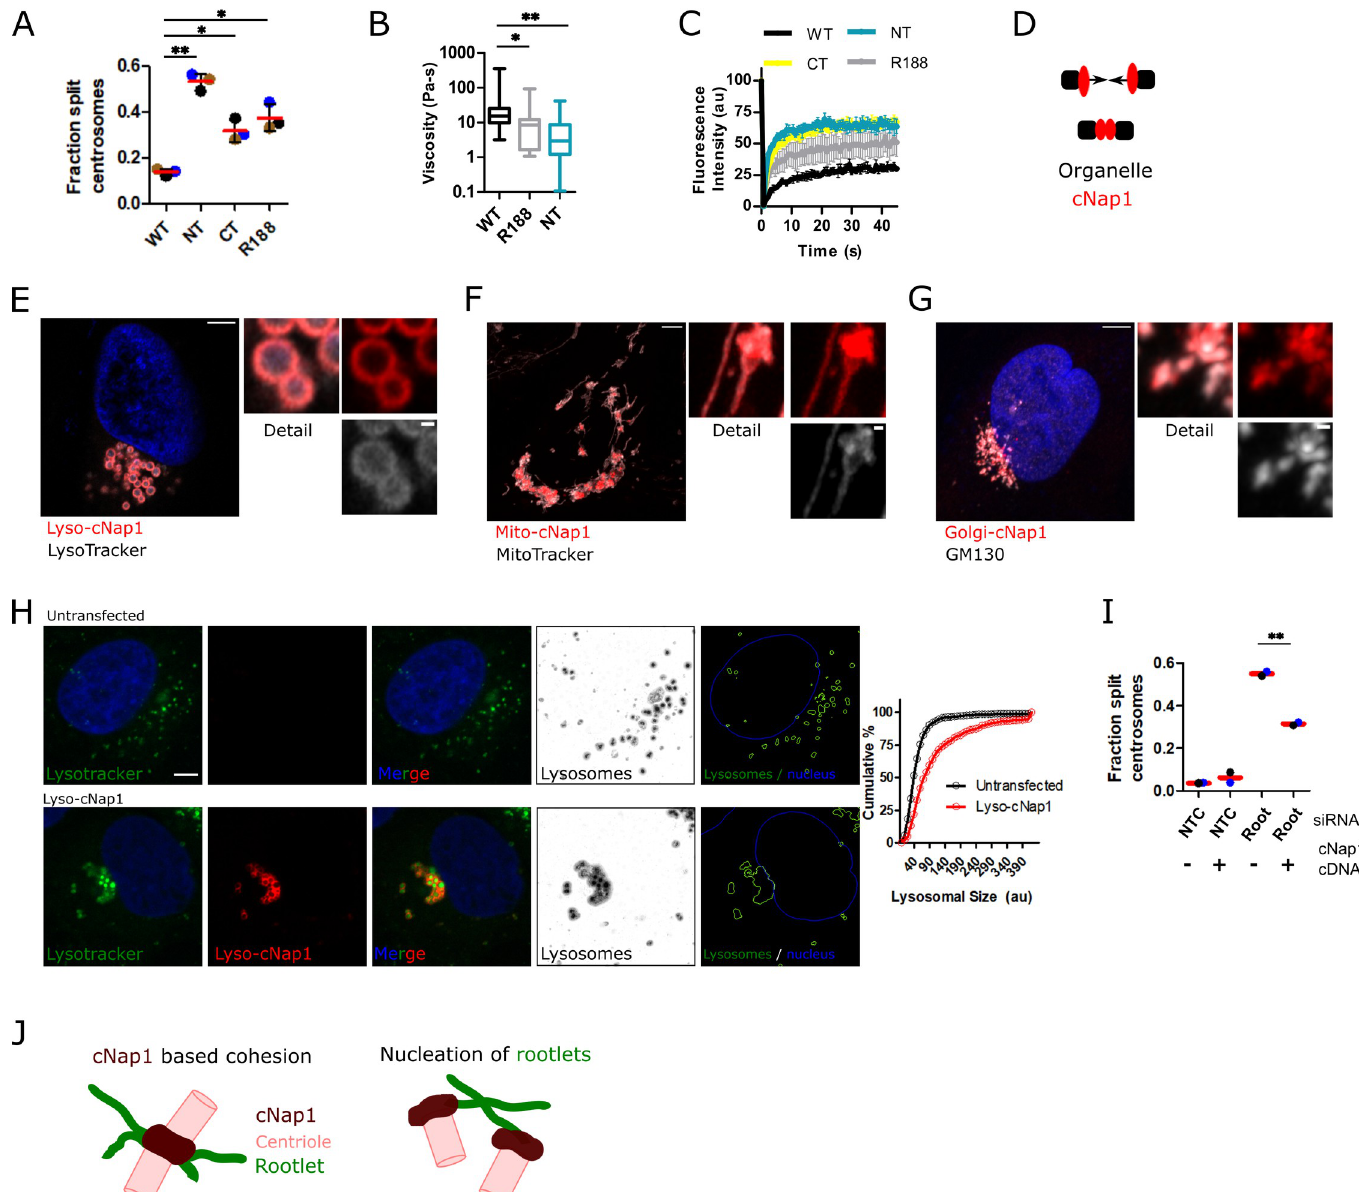
Fig 5. cNap1 is sufficient for organelle cohesion. ( A ) cNap1 truncations NT, CT, and R188 disrupt centrosome cohesion. The bar graph plots the percentage of cells with centrioles separated > 1.6 μ m, determined from anti-PCNT staining and confocal imaging, in 3 experiments, measuring in a minimum of 83 cells in total per condition. The mean and the standard deviation are shown. Dots represent biological repeats, colour coded in sets. The asterisks denote significant differences by paired t test (WT vs. NT P = 0.0014, WT vs. CT P = 0.0379, WT vs. R188 P = 0.0209). ( B ) Viscosity of cNap1 wild type, NT and R188 truncations calculated from the MSD of microsphere movement within them. The box and whiskers plot shows the min to max values and the middle horizontal bars the medians, from 51, 40, and 20 tracks, respectively. ( C ) cNap1 truncations NT, CT, and R188 have an increased rate of FRAP recovery at centrosomes relative to wild type. The graph plots the mean and standard deviation of 3 separate experiments. Approximately 30 cells were measured in each condition. ( D ) Theory that organelle-associated cNap1 promotes organelle spatial proximity. (E ) Lyso-cNap1 (red) forms spherical structures coating LysoTracker positive vesicles (grey). The image shows an Airyscan confocal z-slice. Scale in large image: 5 μ m, scale in detail image: 0.5 μ m. ( F ) Mito-cNap1 (red) localises adjacent to mitochondria as marked by MitoTracker (grey). Scale in large image: 5 μ m, scale in detail image: 0.5 μ m. ( G ) Golgi-cNap1 (red) forms elongated structures adjacent to the Golgi, as shown by co-staining with GM130 (grey). Scale in large image: 5 μ m, scale in detail image: 0.5 μ m. ( H ) LysoTracker positive vesicle localisation in the presence or absence of lyso-cNap1 (bottom and top panels, respectively). The images show Airyscan z-slices of lyso-cNap1 (red), LysoTracker (green), and DNA Hoechst 33342 (blue). The inverted images (marked “lysosomes”) show automated LysoTracker probability segmentation produced in Ilastik. The images marked “lysosomes and nuclei” show binary segmentation produced in CellProfiler. The cumulative histogram quantitates LysoTracker positive vesicle size either with or without lyso-cNap1 expression in approximately 500 cells. ( I ) Loss of centrosome cohesion caused by rootletin siRNA is partially rescued by mScarlet-I-cNap1. The bar graph plots the percentage of cells with centrioles separated > 1.6 μ m, determined from anti-PCNT staining and confocal